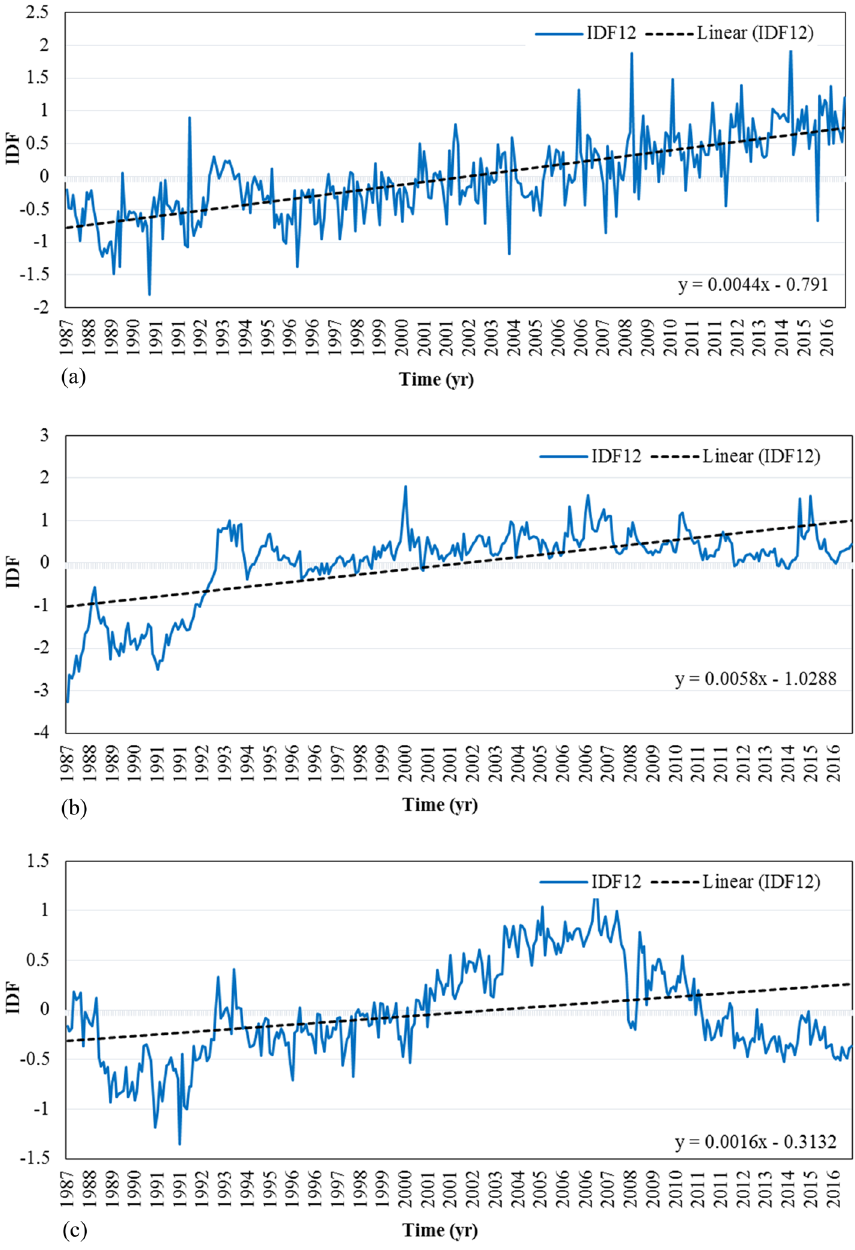
Figure 11. IDF12 time series in ( a ) SSB, ( b ) RSB, and ( c )